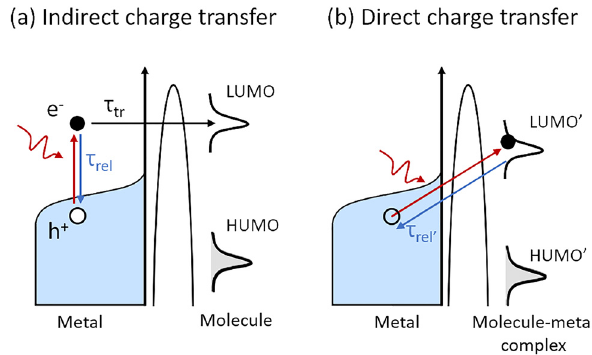
Figure 1: Mechanisms of hot carrier transfer to molecular analytes. (a) In indirect charge transfer, energetic electron is generated in metal and subsequently transferred to analyte. (b) In direct charge transfer, hot electron is generated directly onto the LUMO of molecule – metal complex in one